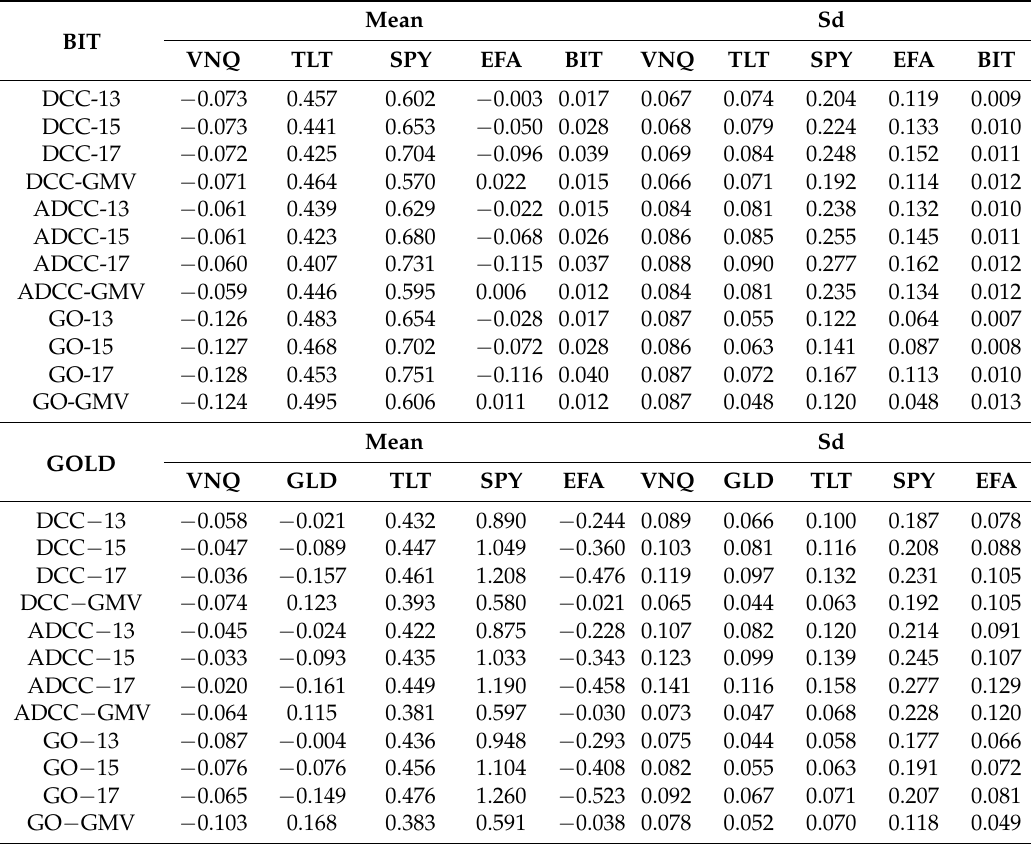
Table 3. Optimal portfolio